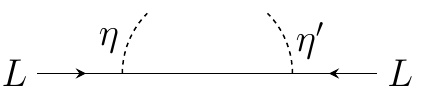
Figure 6 . The particular piece of diagram that generates the 1-loop d = 5 diagram T-3, see (cid:12)gure 2. If this structure exists in any diagram, the vertex with the two scalars (cid:17) , (cid:17) 0 and two Higgses also always exist. This structure appears in many diagrams of the d = 7 topologies.